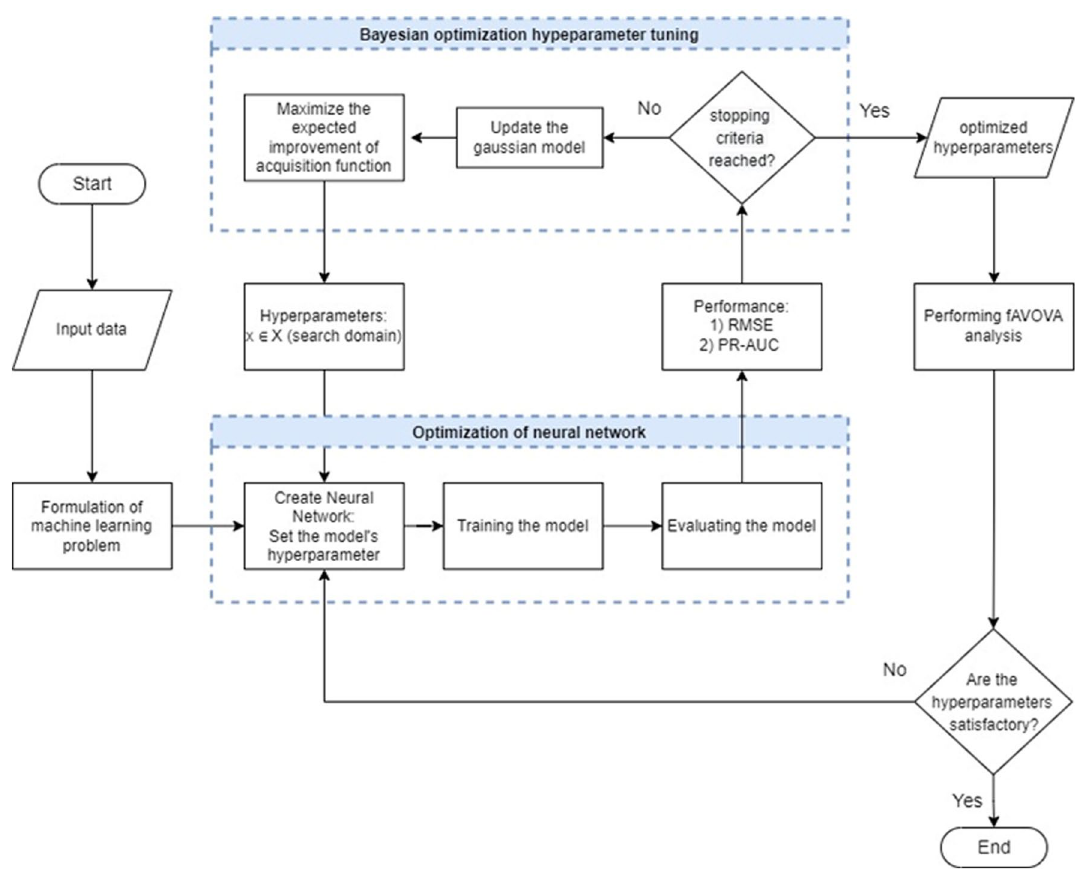
Fig. 6 Overall flowchart of the